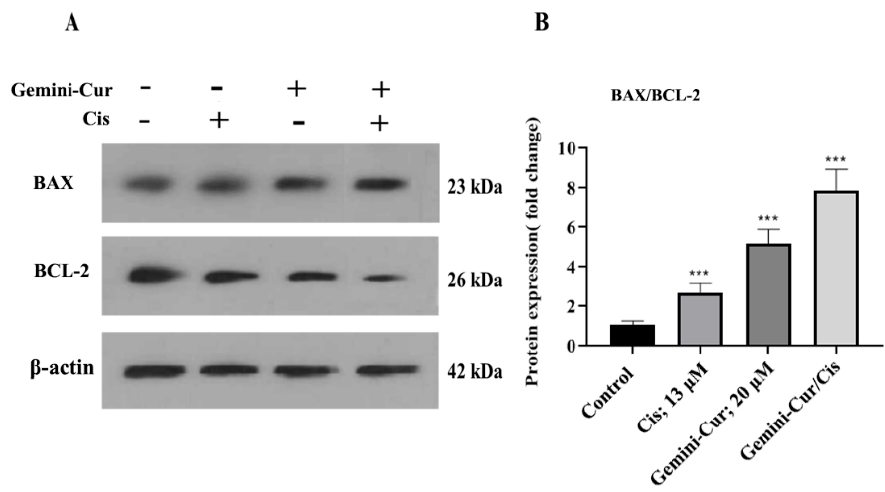
Figure 7. ( A ) Western blotting for BCL-2 and BAX ( A ) proteins. β -actin was used as internal control. ( B ) Data analysis showed that the protein ratio of BAX/BCL-2 is significantly increased in the cells treated with Gemini-Cur/Cis compared to the groups of Cis and Gemini-Cur. Values represent mean ± standard deviation of three independent experiments. *** p < 0.001.